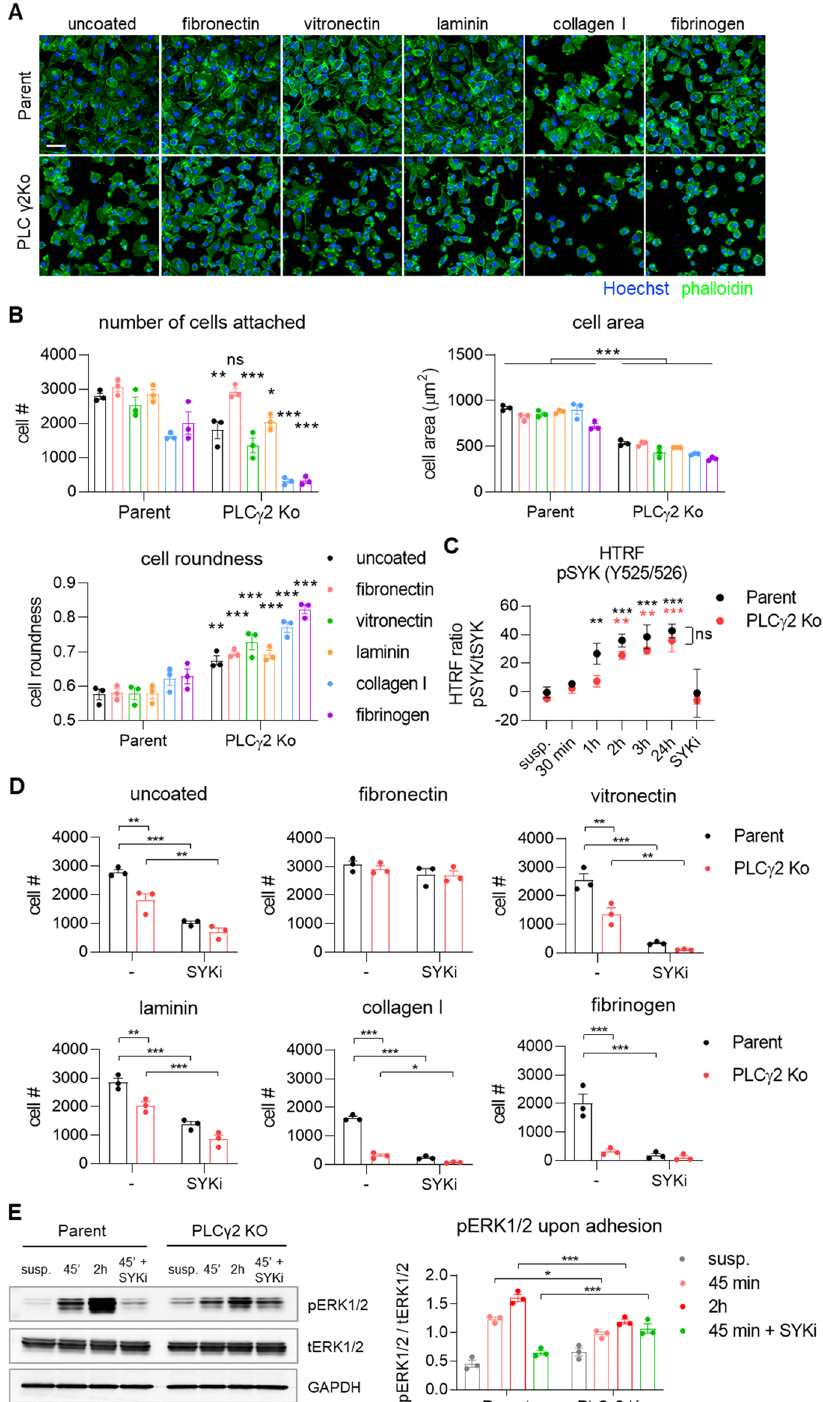
Figure 5. Cell adhesion to different substrates is compromised in PLCγ2 Ko macrophages. ( A ) Representative images of Parent and PLCγ2 Ko cells attached to surfaces coated with the ECM molecules indicated. Scale bar 50 μm ( B ) Quantification of number of cells attached, cell area and cell roundness 3 h after plating on ECM molecules. n = 3; annotations compare Parent vs. PLCγ2 Ko for each coating. ( C ) Phosphorylation of SYK is increased after different time points upon adhesion, as opposed to cells kept in suspension (susp.) in Parent and PLCγ2 Ko line, n = 3; black annotations compare Parent adhered vs. suspension, red annotations compare PLCγ2 Ko adhered vs. suspension ( D ) Effect of SYK inhibition using BIIB-057 (SYKi) on cell adhesion, demonstrating SYK-dependency of adherence to uncoated plates, vitronectin, collagen I, laminin and fibrinogen, but not to fibronectin. n = 3 ( E ) Representative Western blot showing that phosphorylation of ERK1/2 upon adhesion is decreased in PLCγ2 Ko cells. Full immunoblot images are presented in Supplementary Fig. 11. n = 3, data shown represent mean ± SEM, two-way ANOVA followed by Bonferroni’s multiple comparison test. * p < 0.05, ** p < 0.01, *** p <